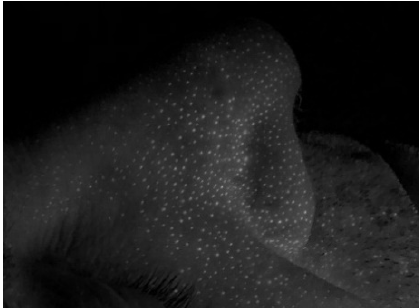
Figure 1. Image of detection of infectious presence of Propionibacterium acnes